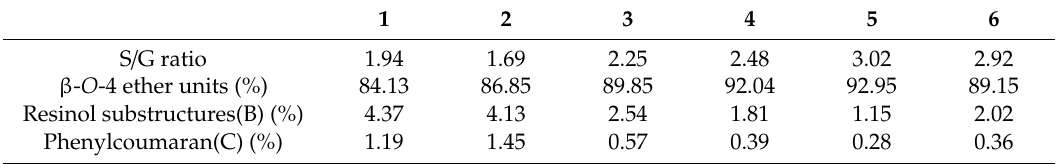
Table 3. Quantification of 1–6 year-old bamboo lignin samples by quantitative 2D-HSQC NMR. 1 2 3 4 5 6 S / G ratio 1.94 β - O -4 ether units (%) 84.13 Resinol substructures(B)